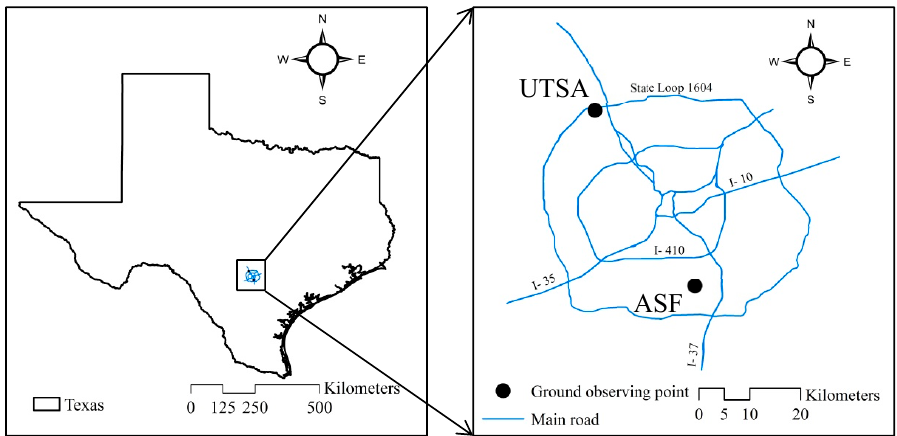
Figure 1. Map of the state of Texas showing the City of San Antonio ( left panel ). The expanded region ( right panel ) shows the sites of the ground observing points (University of Texas at San Antonio [UTSA] and Alamo 1 Solar Farm [ASF]) for solar irradiance (black solid dots) relative to the city’s main roads (reproduced from Reference [27]).